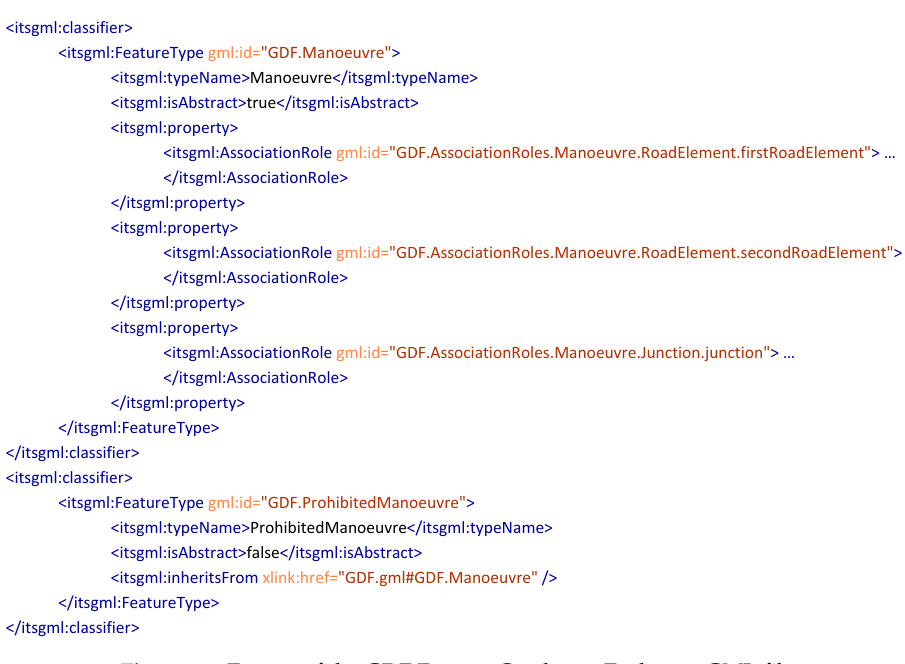
Figure 15. Extract of the GDF Feature Catalogue Exchange GML file.